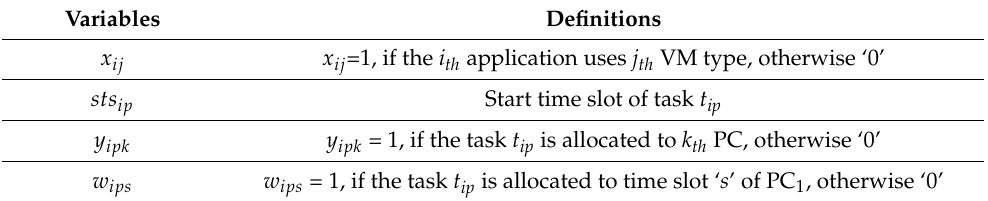
Table 3. Decision